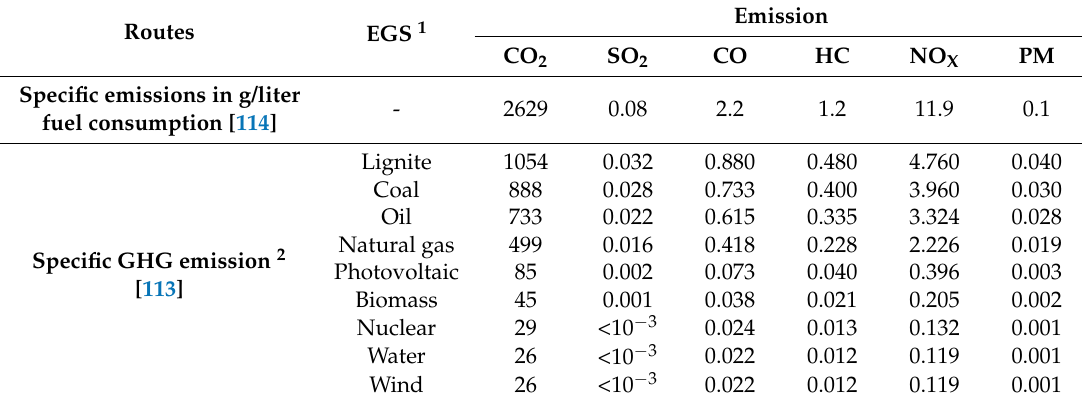
Table 10. Calculated greenhouse gas (GHG) emission depending on the electricity generation source. Routes